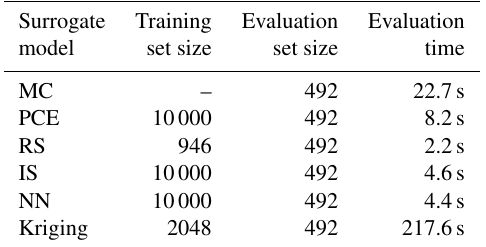
Table 8. Model execution times for the lifetime damage-equivalent fatigue load computations for site